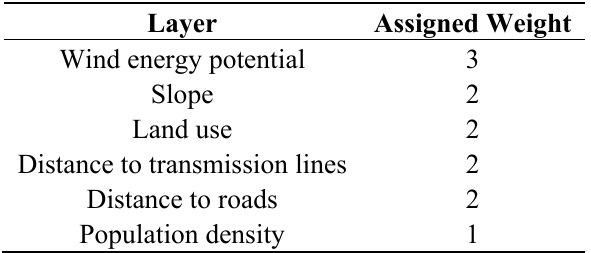
Table 4. Weights assigned to each modeling criterion.